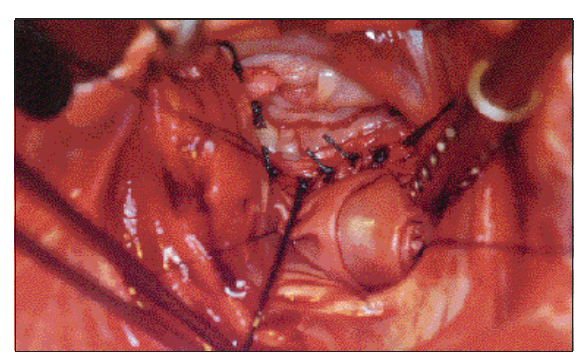
Fig. 7 – Visão cirúrgica do interior do átrio esquerdo. Notar retalho de pericárdio bovino formando novo assoalho (parede posterior) do átrio esquerdo, em continuidade com a anuloplastia mitral.